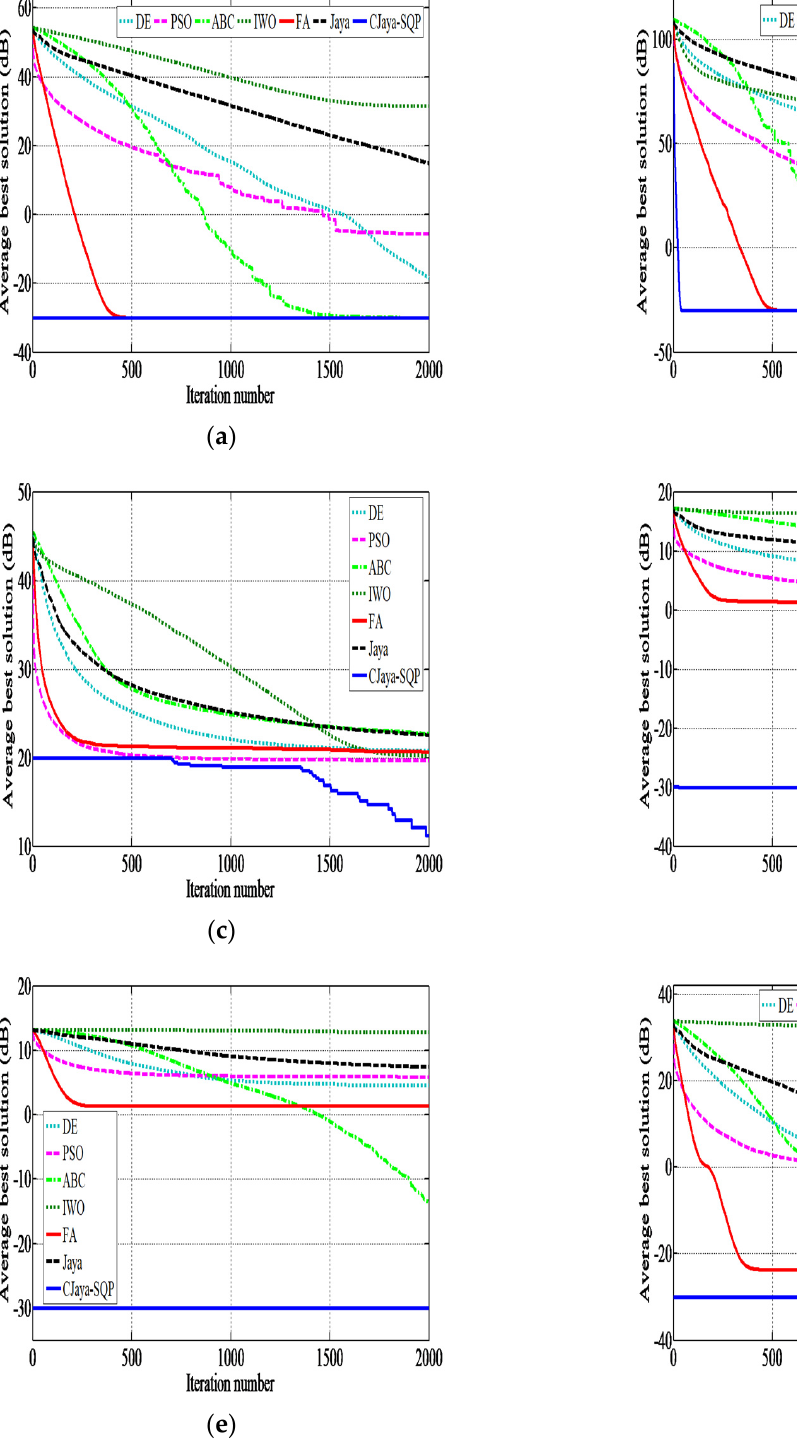
Figure 13. Convergence characteristics of comparative algorithms on the 100-dimensional conven- tional functions: ( a ) f 1 Sphere; ( b ) f 4 Zakharov; ( c ) f 5 Rosenbrock; ( d ) f 7 Salomon; ( e ) f 8 Ackley and ( f ) f 9